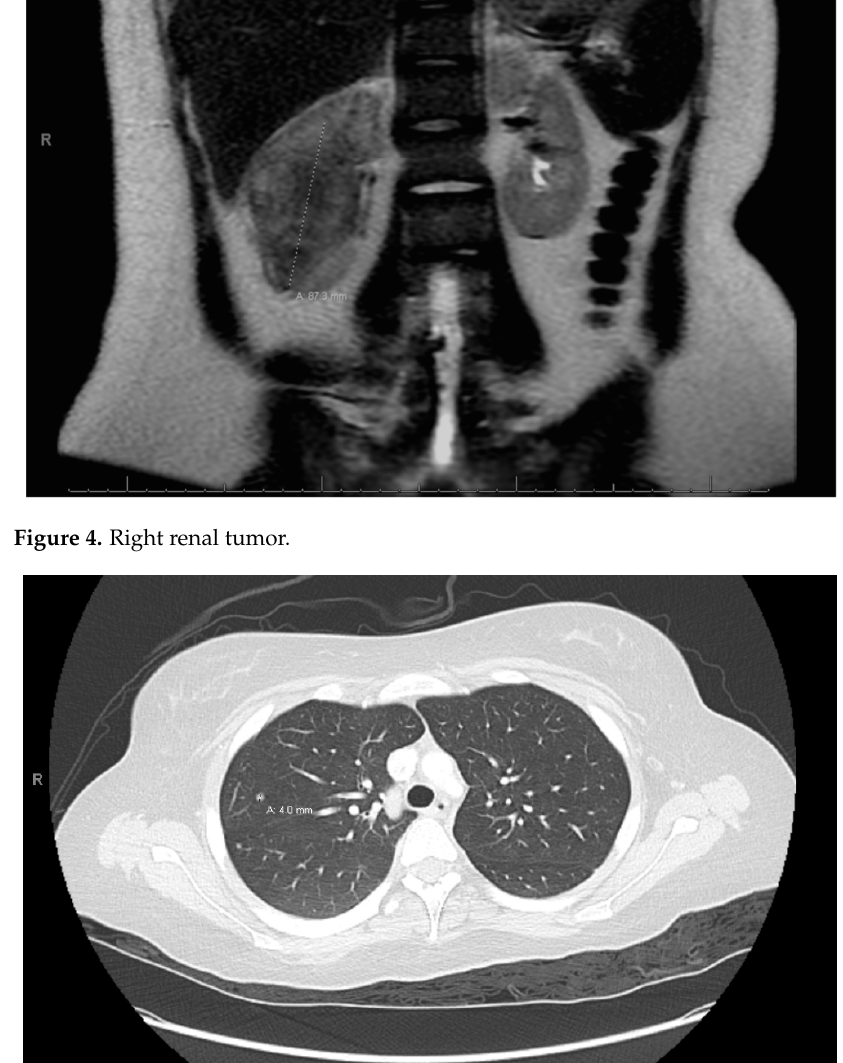
Figure 5. Right lung nodule.